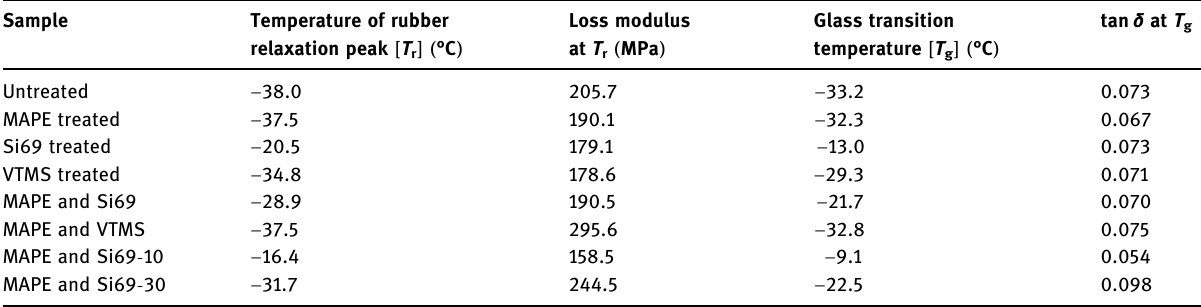
Table 2: Crucial parameters extracted from DMA curves of RubWPC Sample